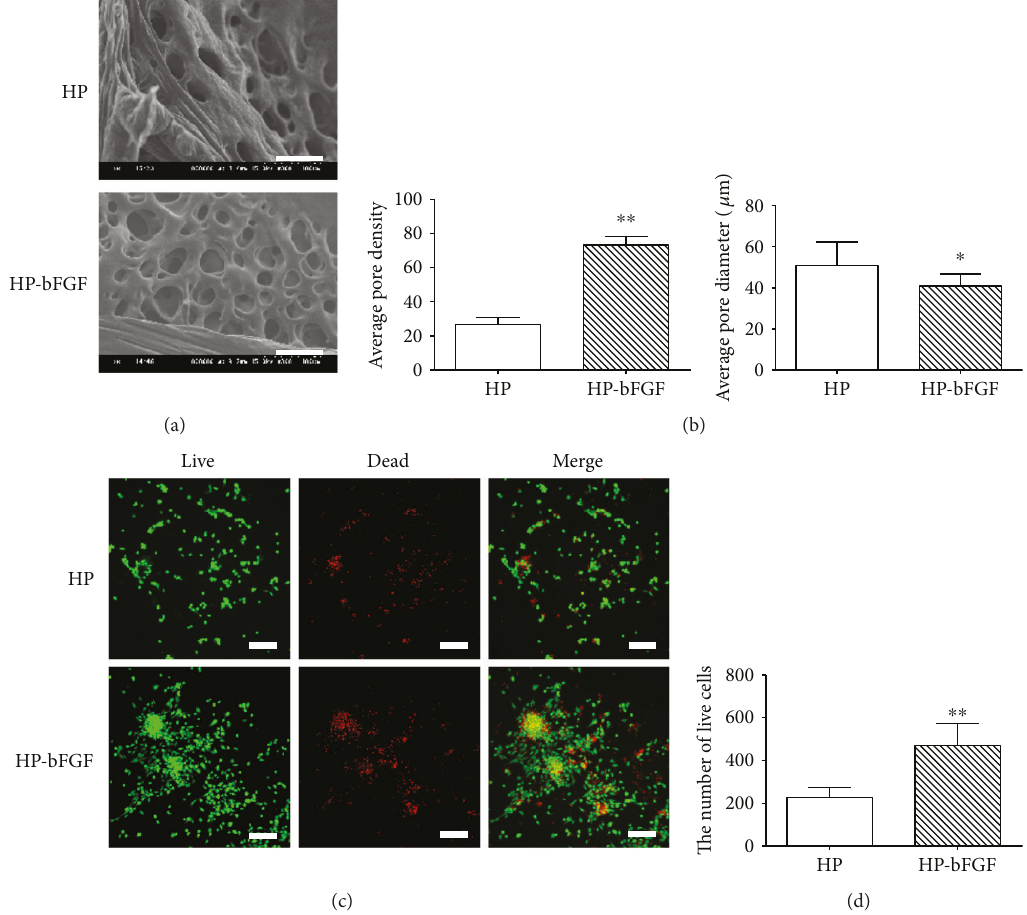
Figure 2: Morphology of HP and HP-bFGF hydrogels and cytocompatibility of hydrogels with DPSCs. (a) SEM images of HP and HP-bFGF hydrogel. Scale bar: 100 μ m. (b) Quanti fi cation of pore density and pore size. (c) Live/Dead staining of cells in HP and HP-bFGF hydrogels at 48 hours. Scale bar: 200 μ m. (d) Quanti fi cation of live cells in HP and HP-bFGF hydrogels by Image J. Data were displayed in mean ± standard error from 3 rats in each group. ∗ P < 0 05 , ∗∗ P < 0 01 versus HP